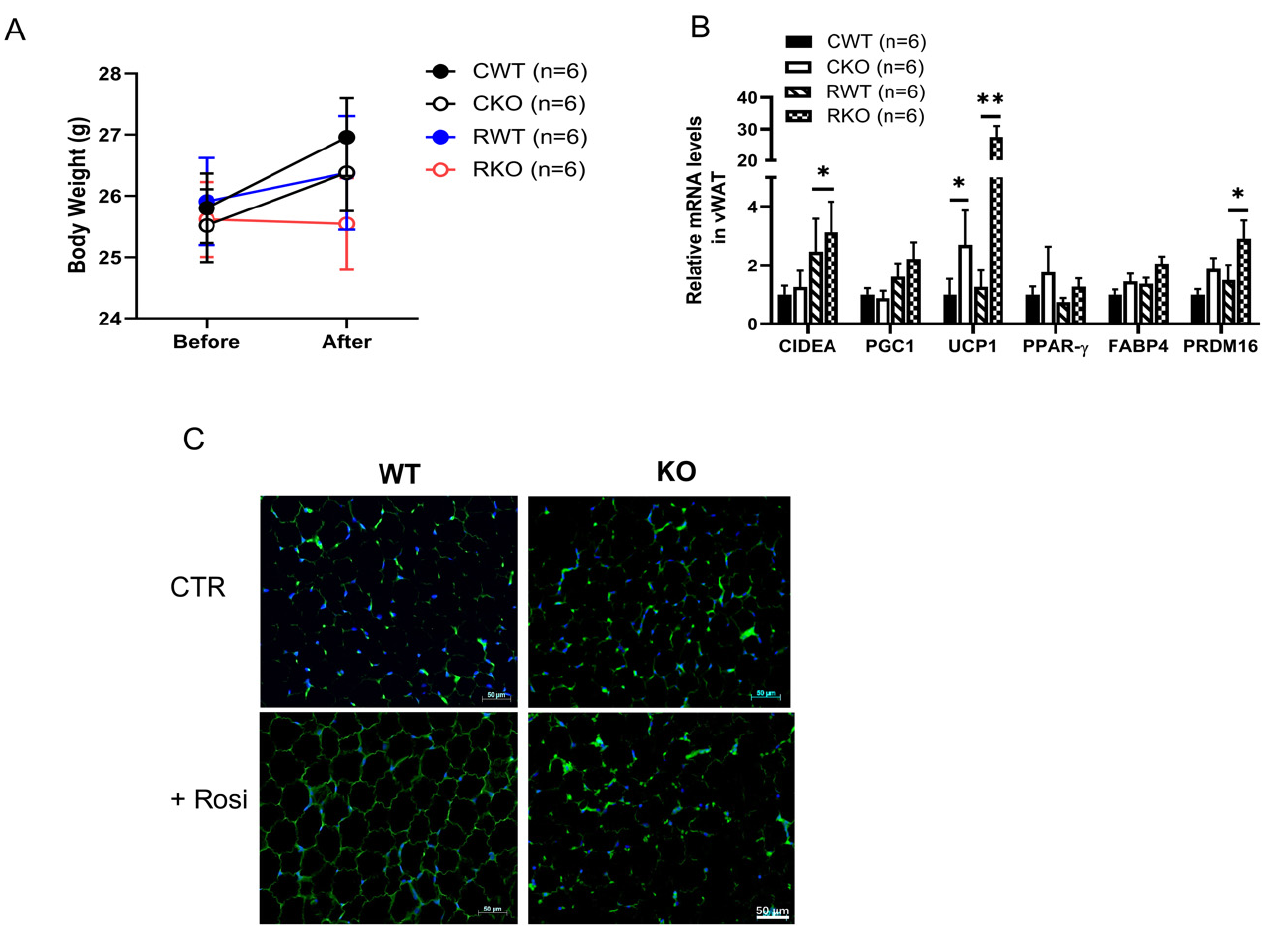
Figure 6. Treatment with rosiglitazone led to bodyweight reduction and vWAT browning in SPL KO compared to WT mice. WT and KO mice were treated with rosiglitazone at 10 mg/kg daily for 10 days. ( A ) Body weight changes in WT mice receiving vehicle (CWT), rosiglitazone (RWT), or SPL KO mice receiving vehicle (CKO) or rosiglitazone (RKO). N = 6 mice per group. ( B ) Expression of browning marker genes at mRNA levels in vWAT tissues from SPL KO and WT mice. ( C ) Immunofluorescent staining of UCP1 in vWAT from rosiglitazone treated WT or SPL KO mice. UCP1: green. Scale bar = 50 µm. 2-way ANOVA with Tukey-Kramer post hoc test was performed to compare differences. * p < 0.05, ** p < 0.01. All data are presented as means ± SEM.